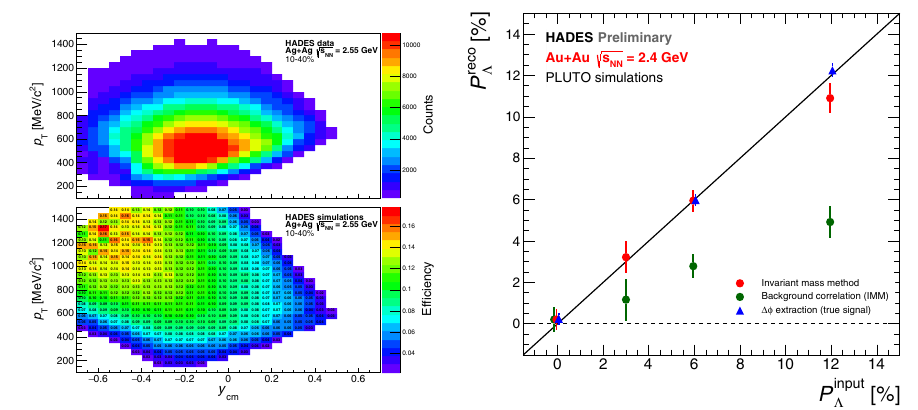
Figure 1. Left panel: Phase-space distribution (top) of the reconstructed Λ hyperons and the corre- sponding reconstruction e ffi ciency (bottom) in Ag + Ag collisions at √ s NN = 2 . 55GeV. Right panel: Extraction of the Λ polarization from Monte-Carlo simulations as a function of the input polarization using two di ff erent methods (blue and red points). The background "polarization" extracted from the invariant mass method is depicted by the green